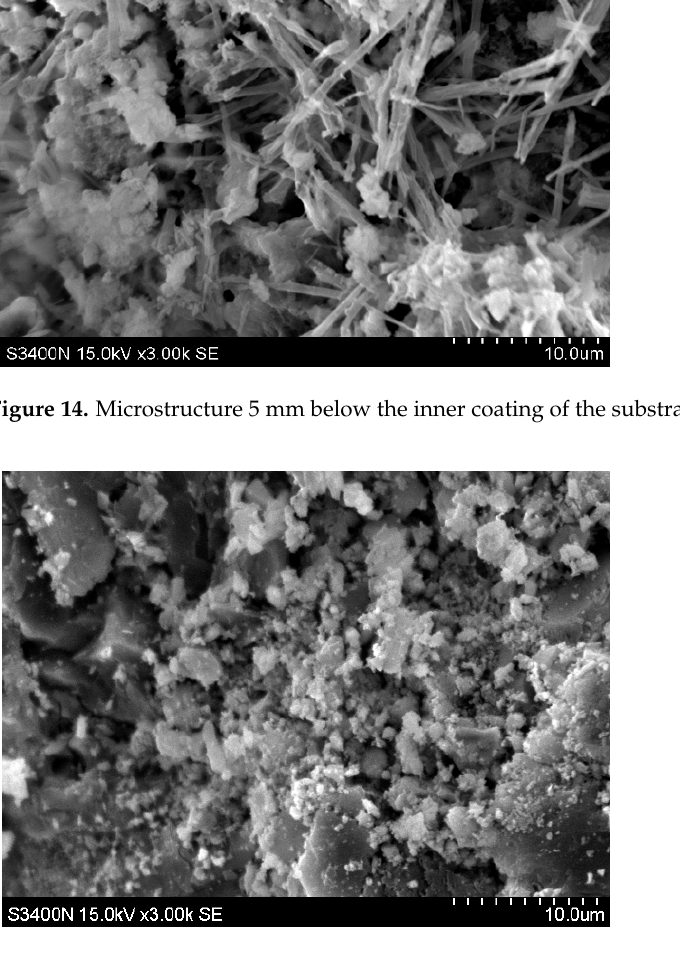
Figure 15. Microstructure 20 mm below the inner coating of the substrate